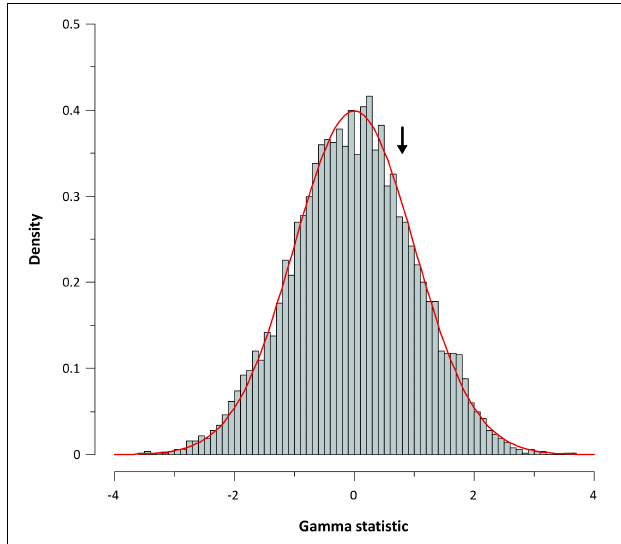
FIGURE 7 | Gamma statistic distribution. Gamma statistic distribution obtained by simulating 5,000 phylogenies under the Yule model. The arrow indicates the empirical gamma ( γ ) value obtained.